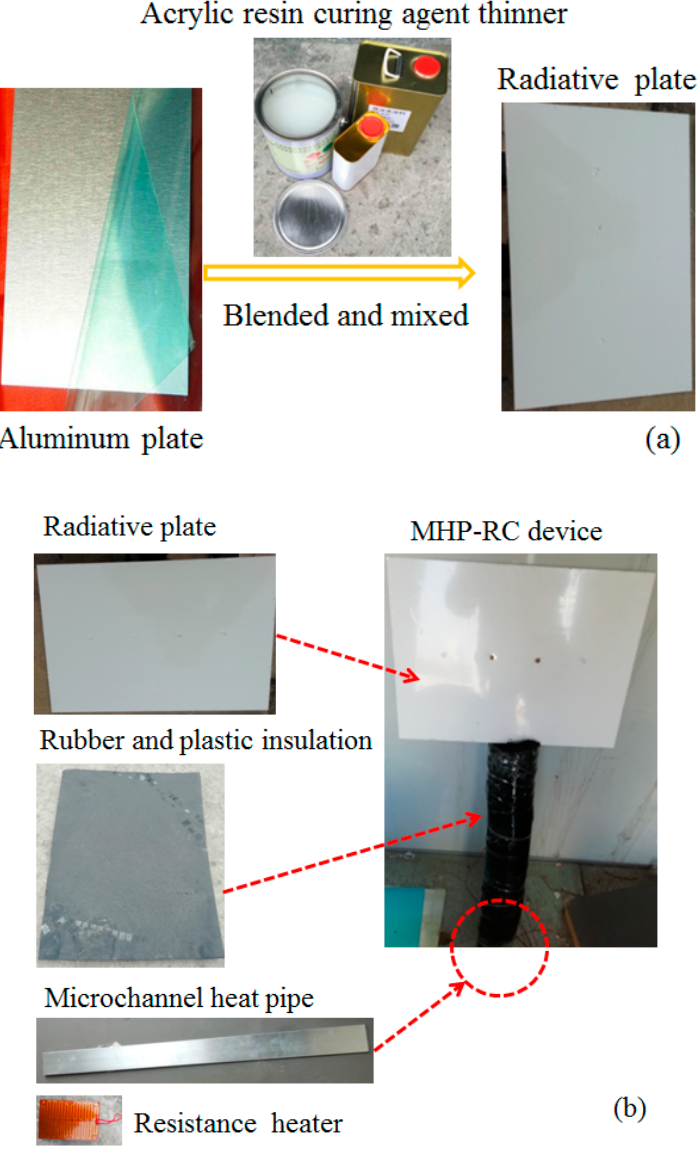
Figure 5. The assembly diagrams of testing rig ( a ) Fabrication of the radiative plate; ( b ) Fabrication of the MHP-RC device).